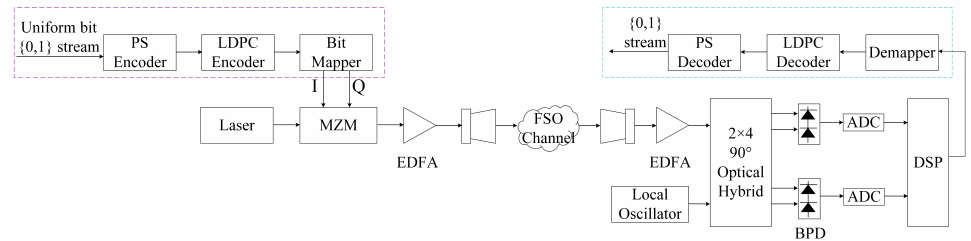
Figure 1. The system structure of the QAM-based PS scheme for the FSO fading